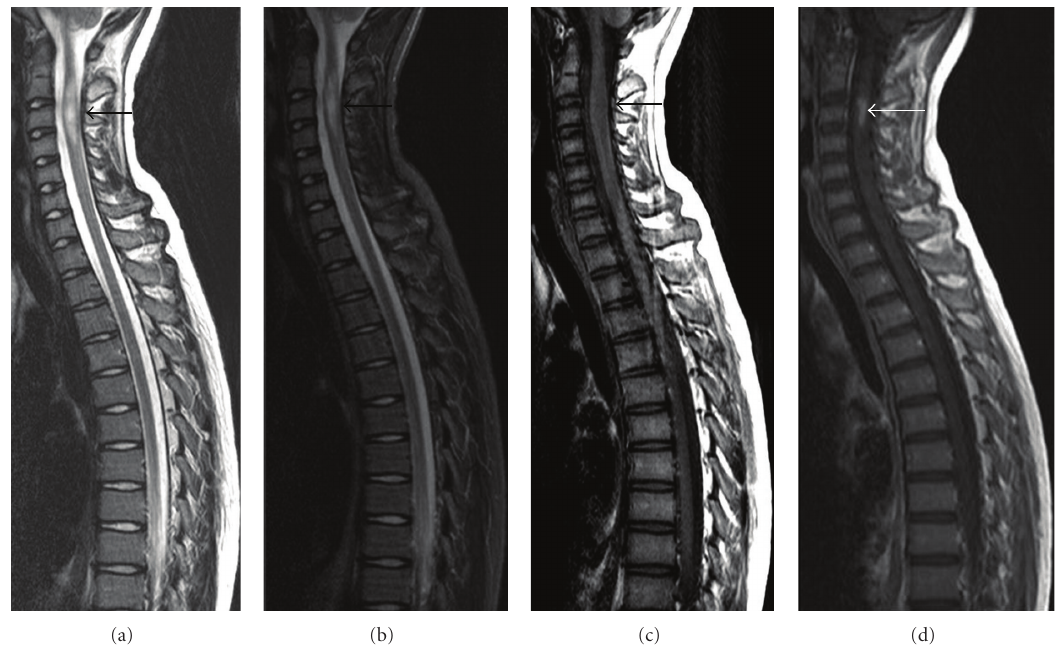
Figure 1: MR images of the cervicodorsal spinal cord. Sagittal T2WI (a) and STIR-T2WI (b) show a well-defined, ovoid-shaped, high- intensity lesion (black arrow) within the cervical cord at C 2 –C 4 , with mild fusiform expansion of the cord. On sagittal T1WI (c), the lesion is slightly hypointense (black arrow). After gadolinium administration (d), the lesion enhances intensely and homogeneously (white arrow).